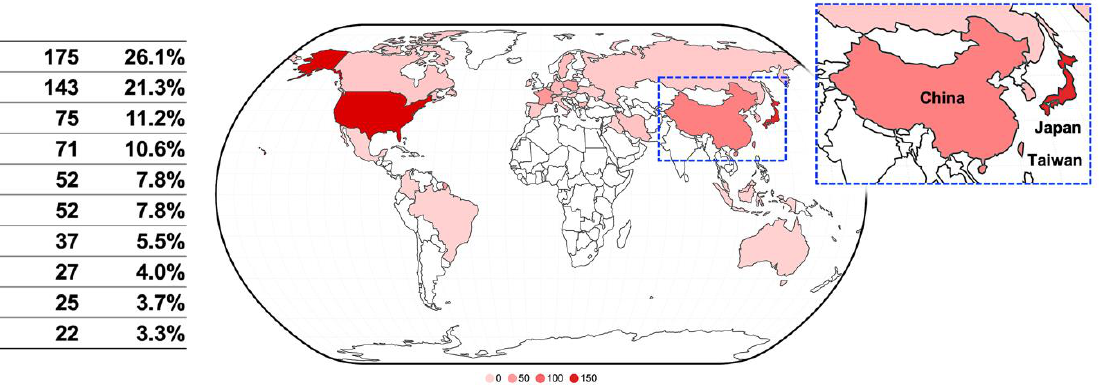
Figure 2. Overview of relevant publications retrieved from Clarivate Analytics’ Web of Science (WoS) bibliometric database. ( a ) The corresponding annual publication counts. ( b ) The top 10 authors contributing the most to the area of PCSEL.